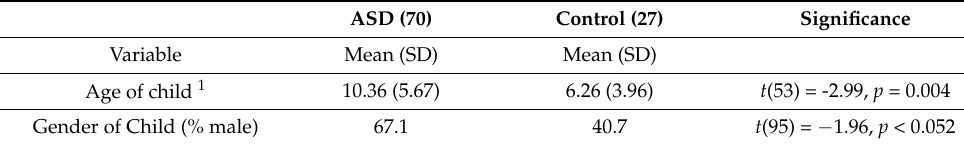
Note. 1 48 parents did not report their child’s